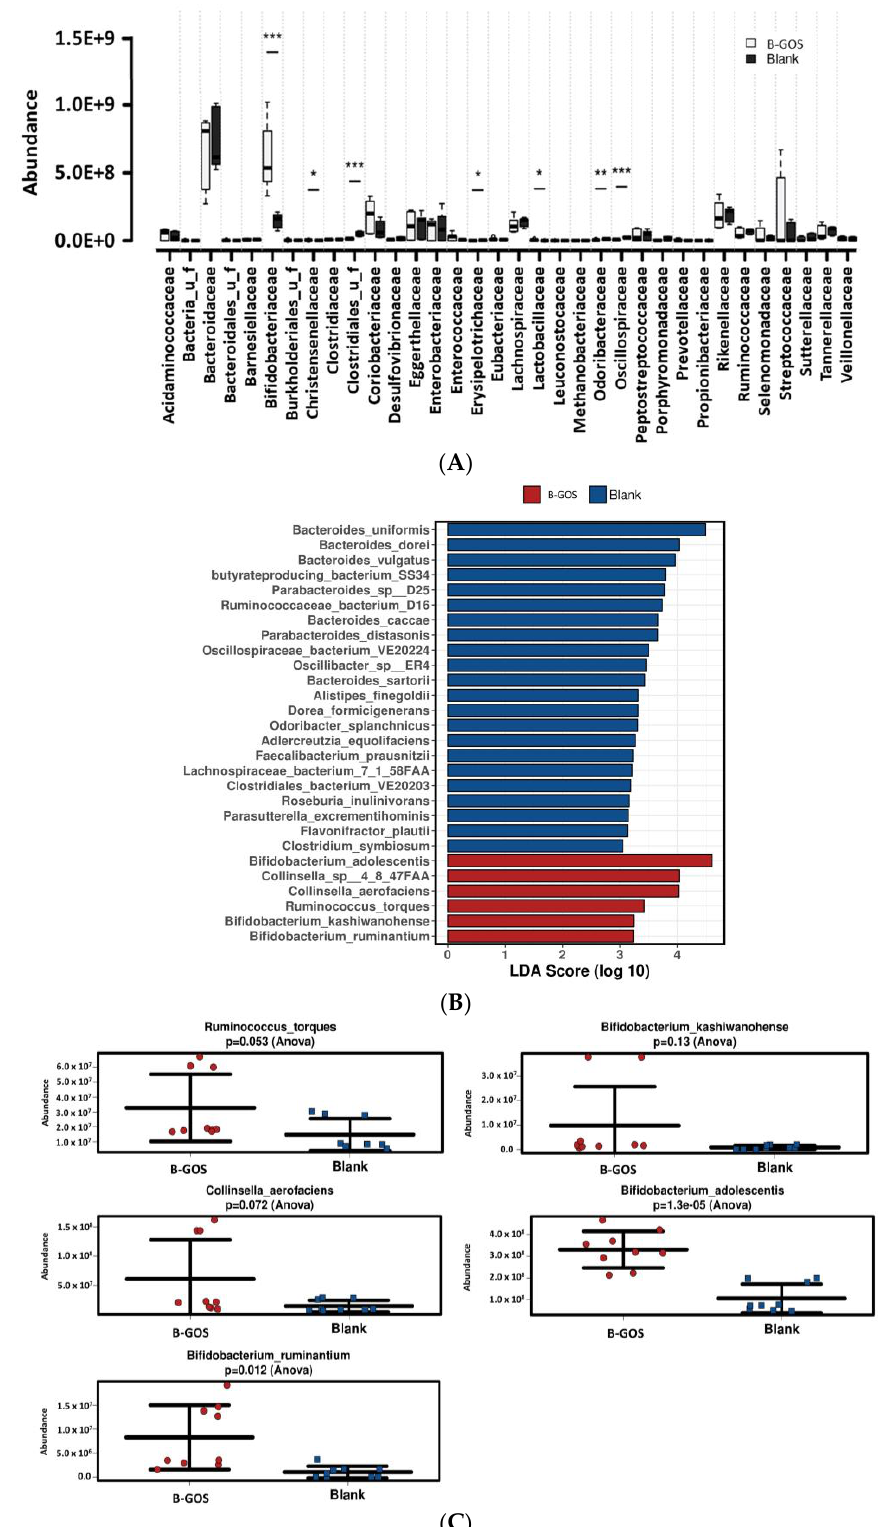
Figure 6. Changes in the microbial community composition ( A ) absolute abundances (family level) 24 h after treatment, ( B ) linear discriminant analysis effect size of absolute abundances (species level) 24 h after treatment, ( C ) boxplots for the most important enrichments (species level) 24 h after treatment. *: p < 0.05, **: p < 0.01, ***: p < 0.001. GOS = Bimuno ® galactooligosaccharide; LDA = linear discriminant